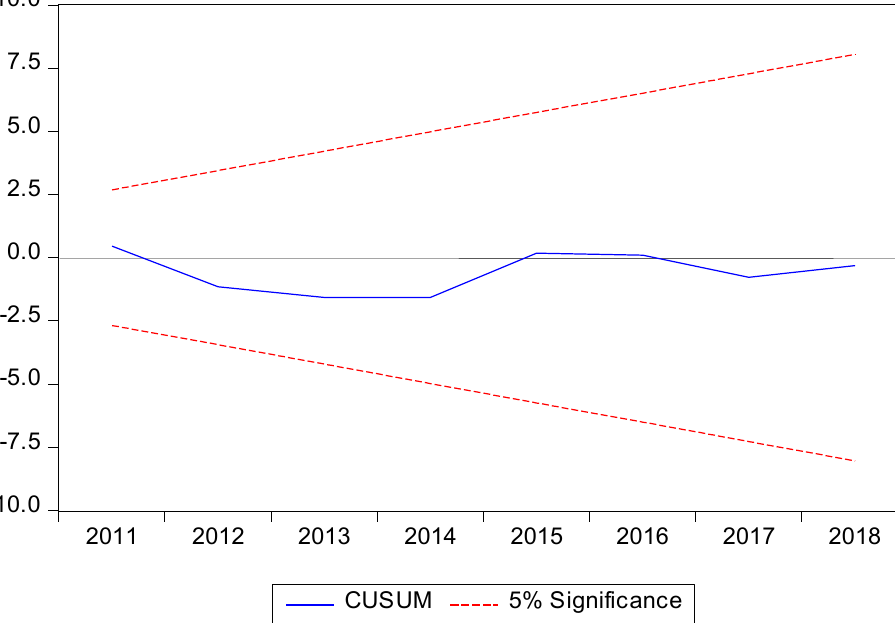
Figure 2: Plots of the Cumulative Sum (CUSUM) of squares of recursive residuals